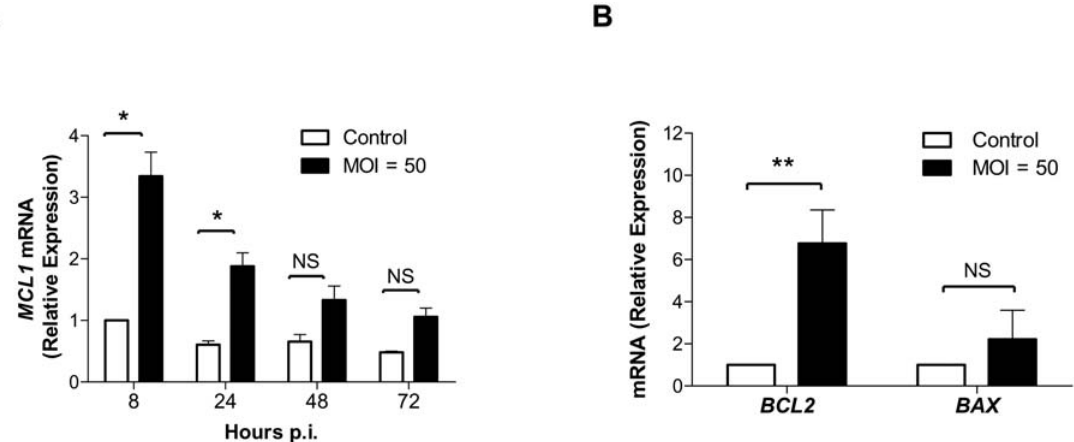
Figure 8. Staphylococcal infection of hMDMs results in changes in expression of apoptosis-related genes. ( A ) Upregulation of the antiapoptotic MCL1 gene in hMDMs. The expression level of MCL1 in uninfected and S. aureus -infected macrophages was monitored by quantitative real-time RT-PCR as described in the Materials and Methods. Data given are the mean values calculated from the results of three independent real time reactions. ( B ) Relative changes in mRNA expression of BCL2 and BAX 8 h after S. aureus phagocytosis by macrophages. The data shown is representative of three separate experiments, performed in triplicate, using hMDMs derived from different donors. Bars represent mean relative expression 6 SD; *, p , 0.05; **, p , 0.01; NS, not significant.